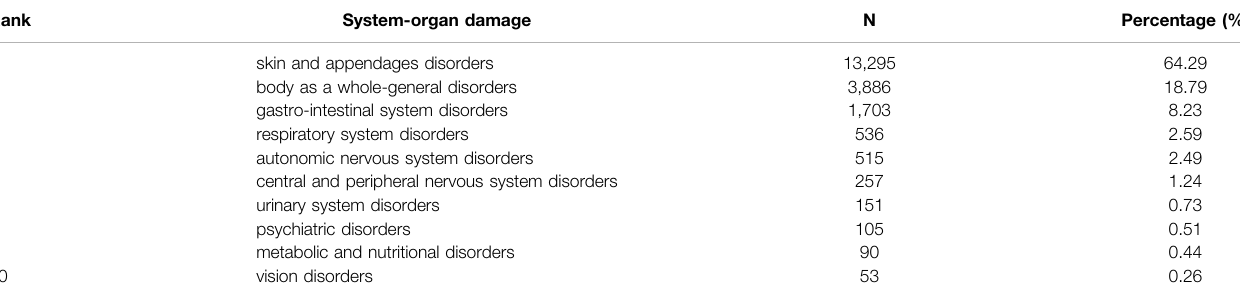
TABLE 5 | Number and percentage of ADR events related to system-organ damage (top 10, n (cid:1) 20,681). Rank System-organ damage N Percentage